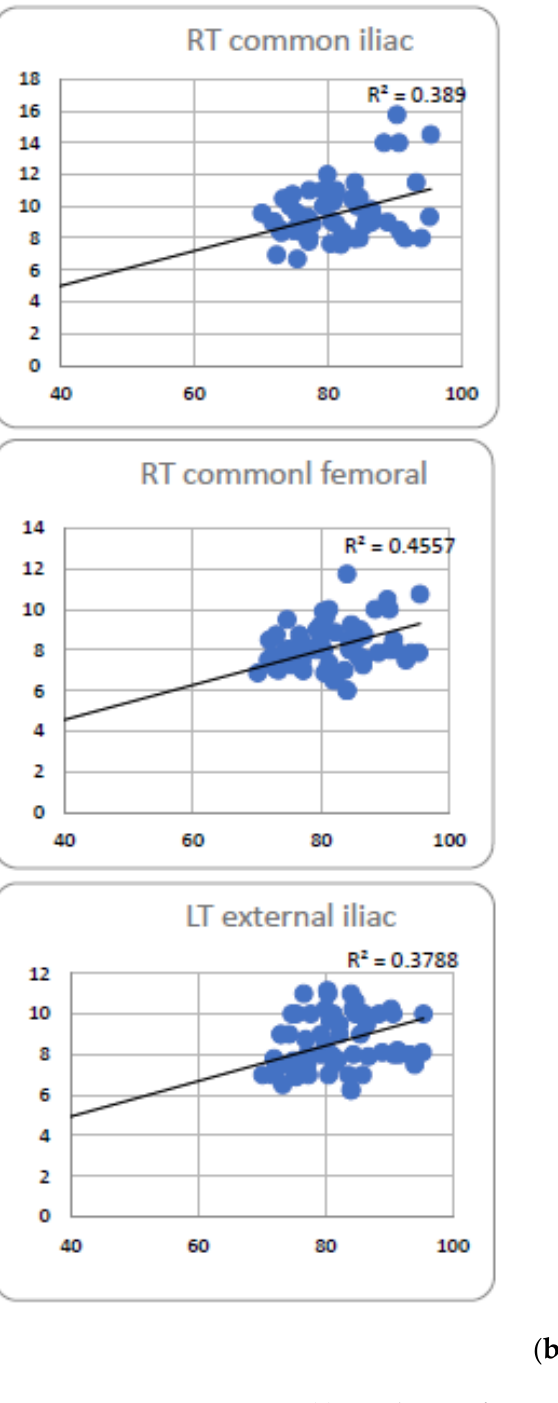
Figure 5. ( a ) Correlations of perimeters of the aortic annulus (mm, horizontal axis) versus peripheral vessels diameters (mm, vertical axis) among the total study population (n = 139); ( b ) Correlations of perimeters of the aortic annulus (mm, vertical axis) versus peripheral vessels diameters (mm, horizonal axis) male population (n = 63).